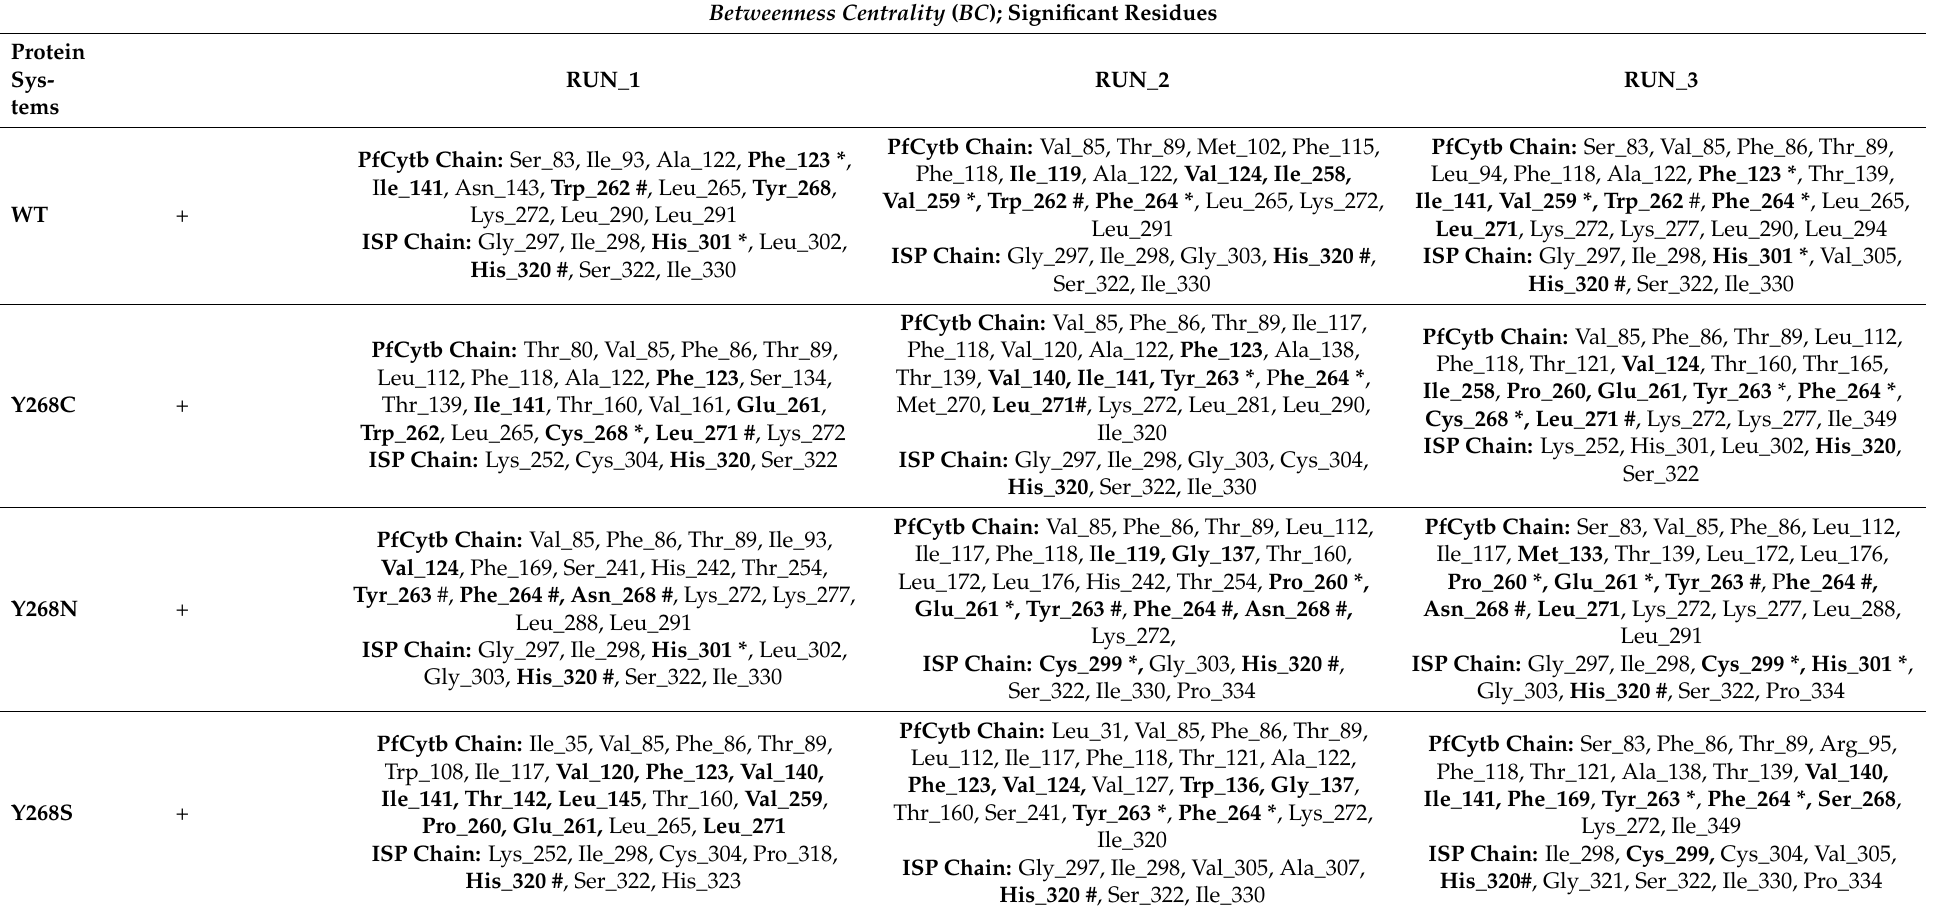
Table 2. Protein residues having high normalized Betweenness Centrality (BC) values in holo WT and three mutant systems across the triplicate runs; + sign indicate significant high values. Active site residues are shown in bold. The * and # suffixes indicate common residues across 3 runs and 3 runs, respectively. (A threshold value of ± 2 standard deviations (SD) of the BC values was used for each